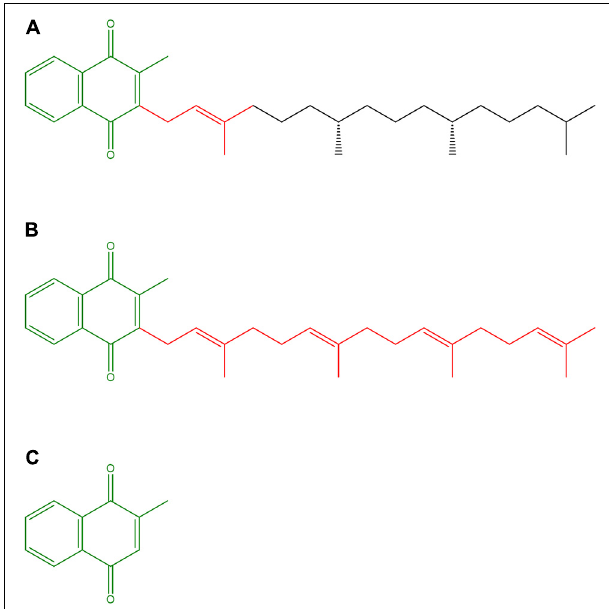
FIGURE 1 | Structures of vitamin K vitamers. (A) Phylloquinone or Vitamin K1; (B) Menaquinone-4 or Vitamin K2; (C) Menadione or Vitamin K3. The 2-methyl-1,4-naphthoquinone nucleus and the (poly)isoprenoid side chains are highlighted in olive and red,